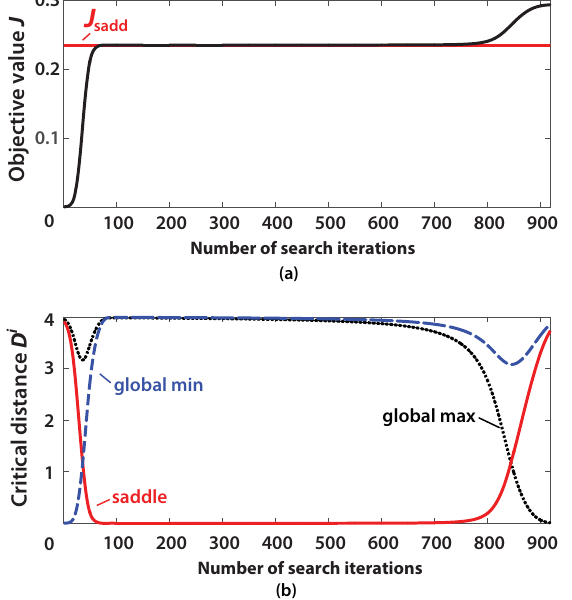
Fig. 5 Effect of saddle points in the search for globally optimal controls. (a) The search being strongly attracted to a saddle submanifold at J sadd ; (b) the distance D i to particular critical points duing a climb of the landscape. This extreme circumstance was chosen as a worst case scenario. Reproduced with permission from Ref. [59], (cid:13) C 2017 APS.